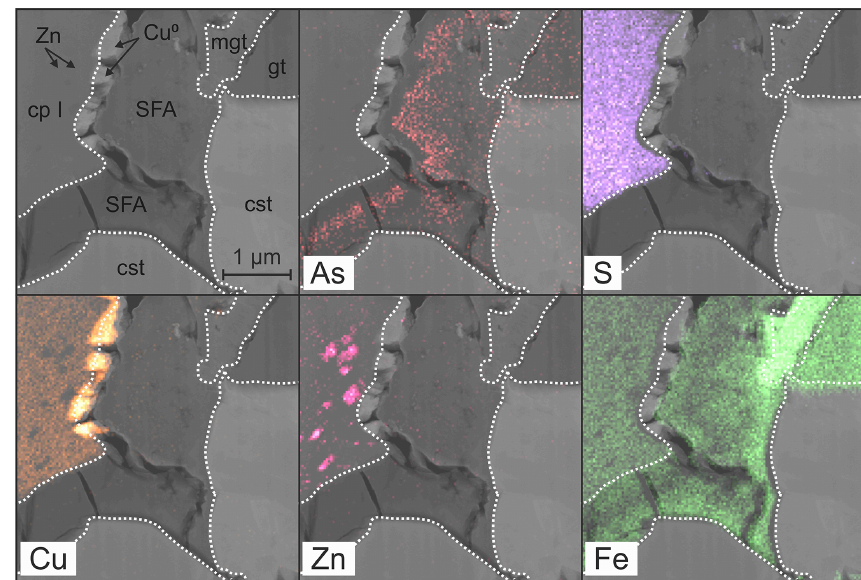
Figure 7. EDX maps of the area indicated in Fig.